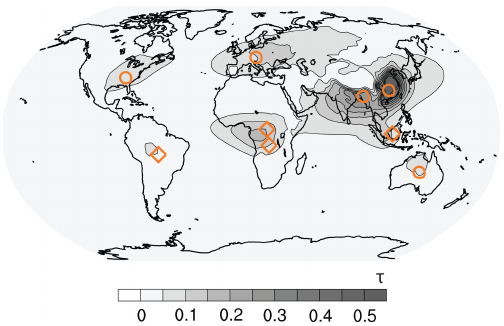
Figure 1. Anthropogenic aerosol optical depth of MACv2-SP for 2005. Locations of the nine aerosol plume centres are marked in orange with circles representing industrial pollution and rectangles representing seasonally active biomass